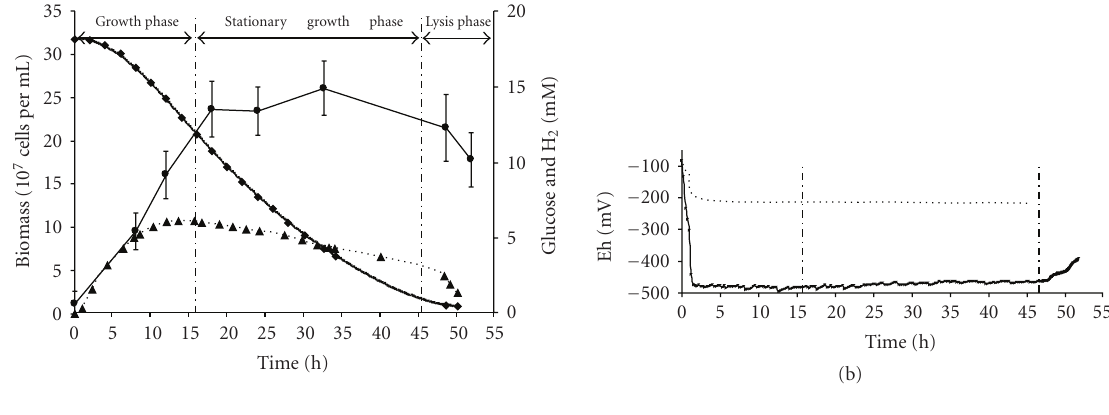
Figure 1: Growth of Thermotoga maritima cultivated in a bioreactor under anoxic conditions: (a) biomass ( ( ) and (b) redox potential (Eh) of noninoculated medium (discontinuous line) and T. maritima -inoculated medium (continuous line). (cid:2)